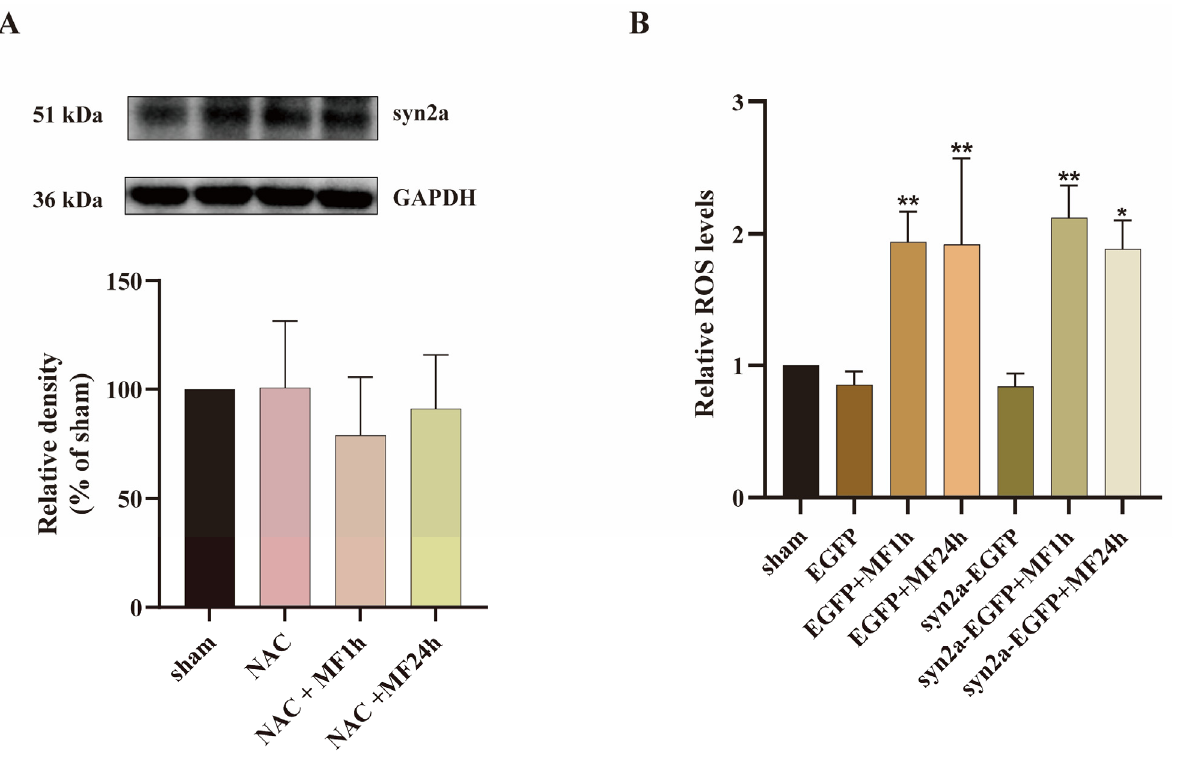
Figure 5. 50-Hz MF inhibited syn2a expression via increasing ROS. ( A ) NAC pretreatment rescued MF-inhibited syn2a expression in zebrafish larvae; ( B ) Syn2a overexpression did not affect MF-enhanced ROS in zebrafish larvae. * p < 0.05, ** p < 0.01, compared with sham.